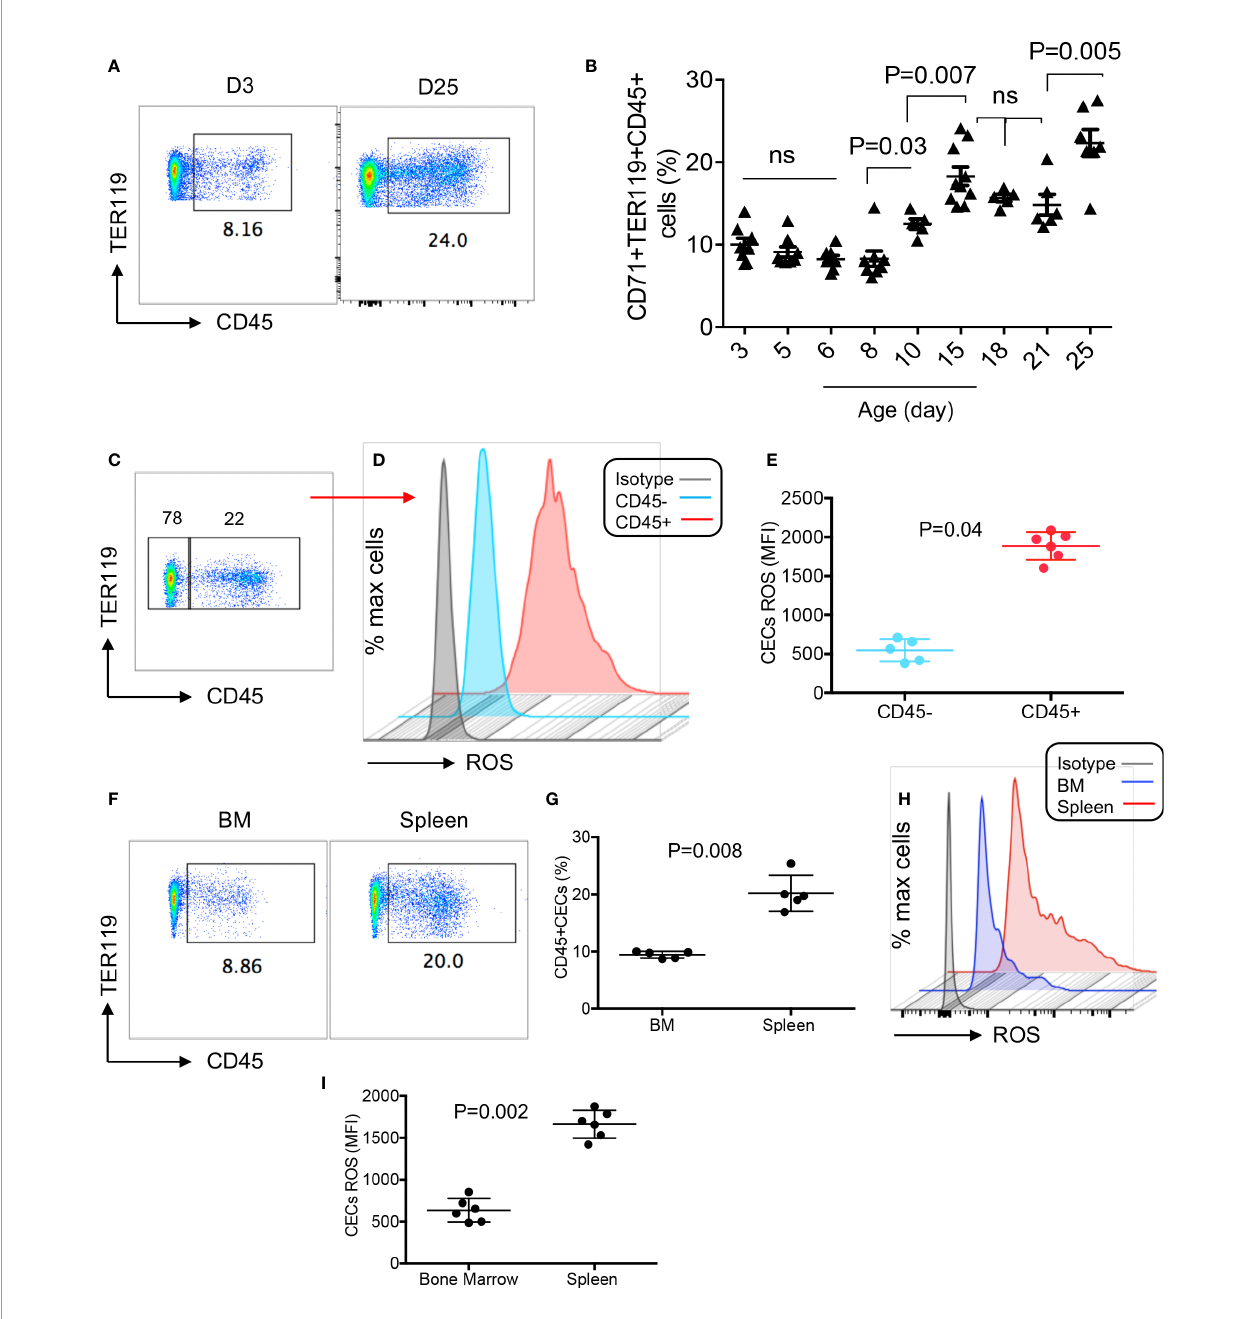
FIGURE 3 | Differential expression of ROS by CD45+ and CD45 − CECs in mice. (A) Representative plots showing percentages of CD45+ subpopulation among mice splenic CECs at day-3 and day-25. (B) Cumulative data showing percentages of CD45+ CECs among splenic mice CECs from day 3 to day 25. (C) Representative plot of CD45 expressing CECs in splenic CECs of a 15-day-old mice. (D) Representative histogram of ROS expression in CD45+ versus CD45 − CECs from the spleen of a 15-day-old mouse. (E) Cumulative data showing mean fl uorescence intensity (MFI) of ROS in CD45 + /CD45 − CECs of neonatal mice (day 15). (F) Representative plots of CD45 expression among splenic CECs versus their counterparts in the bone marrow (BM) of 15-day-old mice. (G) Cumulative data showing percentages of CD45+ CECs in the spleen versus bone marrow on neonatal mice. (H) Representative histogram of ROS expression in total CECs in the bone marrow compared to the spleen of a day-15 mouse. (I) Cumulative data showing mean fl uorescence intensity (MFI) of ROS in the bone marrow versus spleen of neonatal